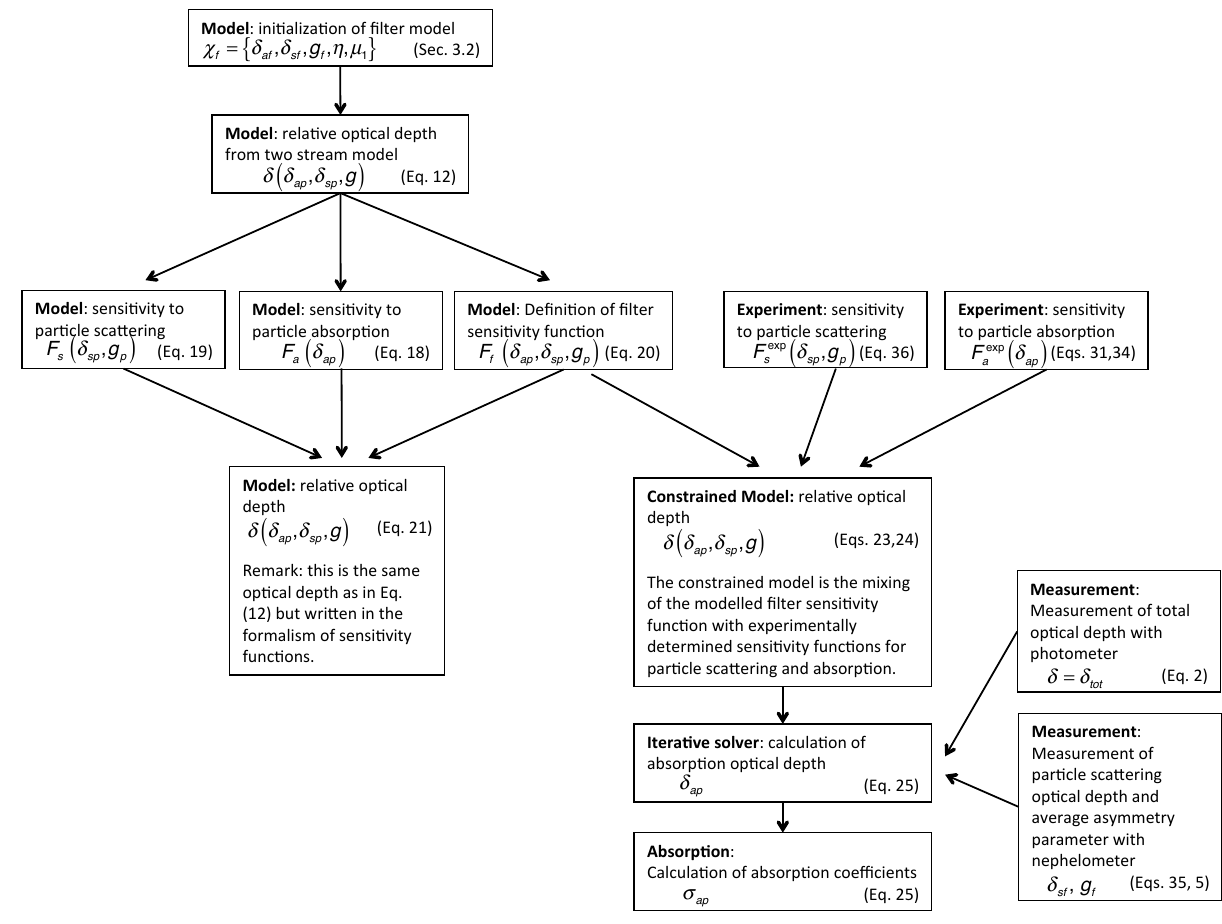
Figure 8. Overview of model implementation, constraints to experimental sensitivity functions, and retrieval of absorption from measure- ments with absorption photometers and measurements of scattering